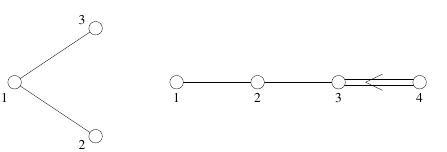
Figure 1 . The Dynkin diagram, with our conventions for numbering of the nodes, of D 3 ⊕ C 4 ’ so (6) ⊕ sp (8)